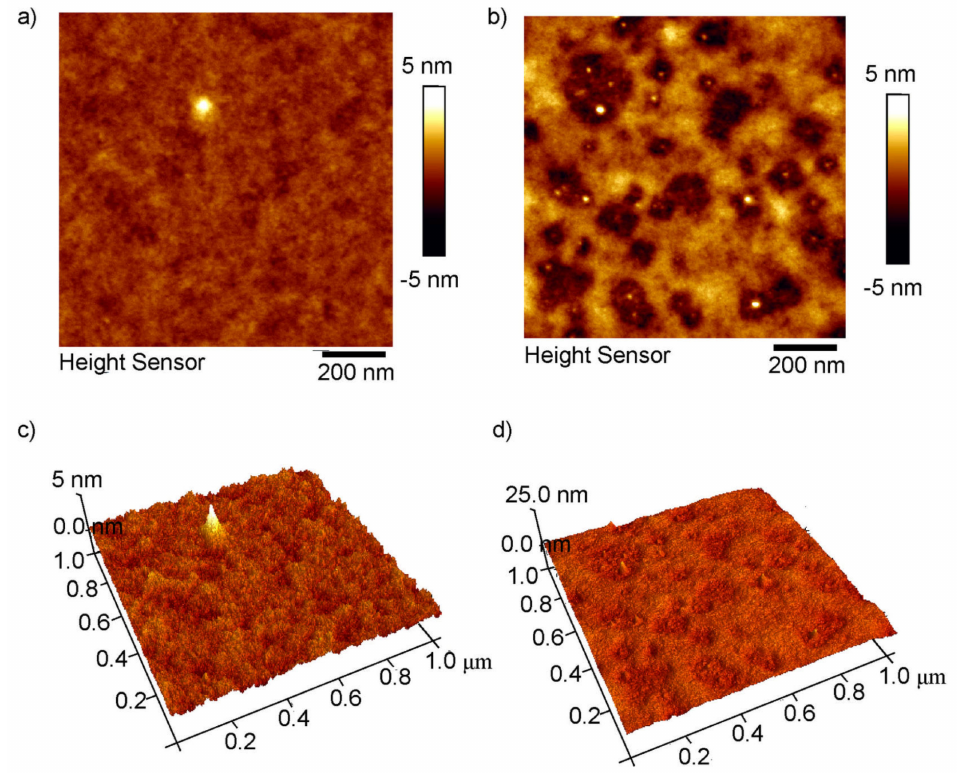
Figure 5. Atomic force microscopy (AFM) images and corresponding 3D surface visualization of samples S45 ( a , c ) and S85 ( b , d